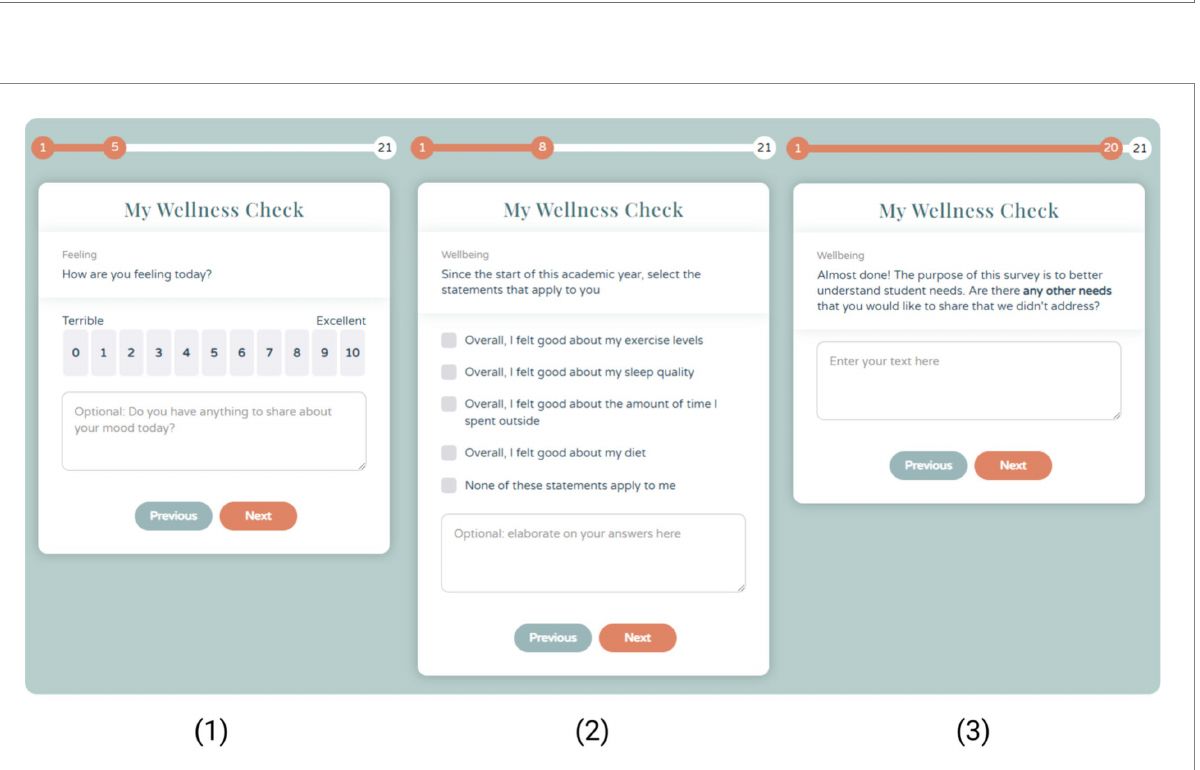
FIGURE 5 A selection of images depicting the appearance of the survey experience. The first screen shows a rating item about life satisfaction, the second, a checkbox item about physical wellbeing, and the third item shows a free text item about their additional wellbeing